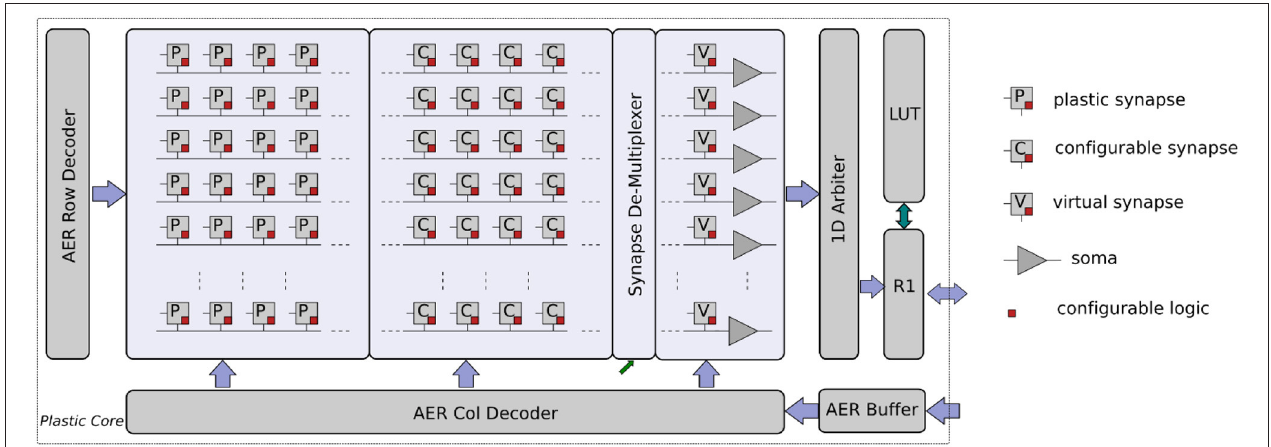
FIGURE 16 | Plastic core architecture. It comprises a 64 × 128 array of plastic synapses, a 64 × 64 array of non-plastic synapses, a 64 × 4 array of time-multiplexed linear synapses, a synapse row de-multiplexer, and 64 adaptive I&F neurons. Each synapse has digital memory and configuration logic circuits. In addition, there